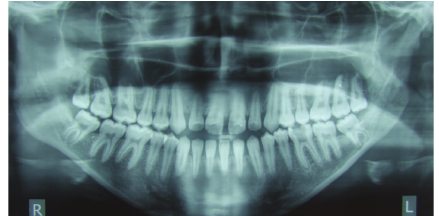
Figure 6: Pretreatment orthopantomogram (OPG).